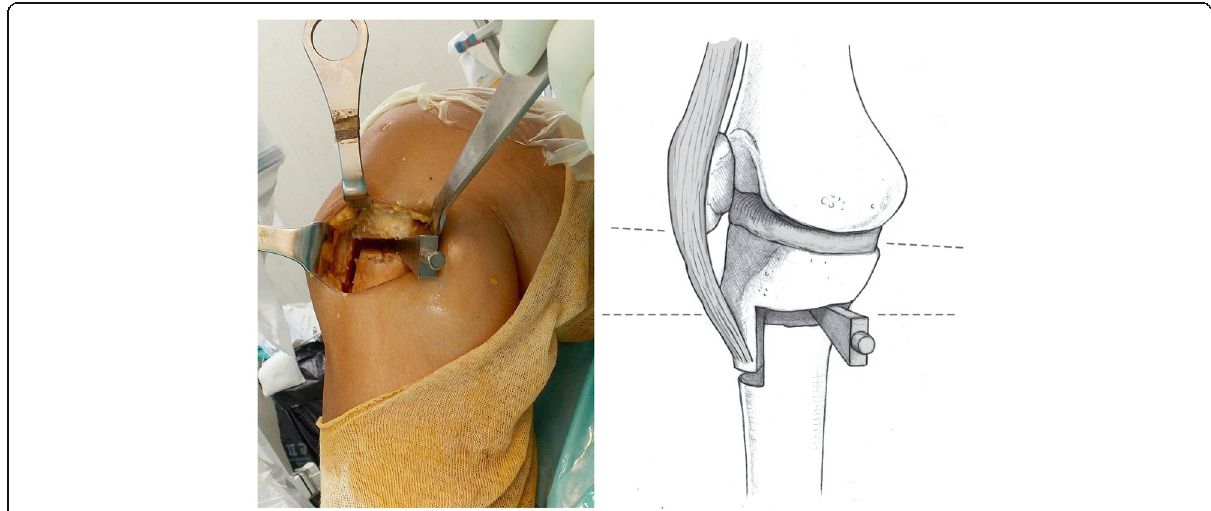
Fig. 3 Graduated wedge at the level of the posterior tibial cortex